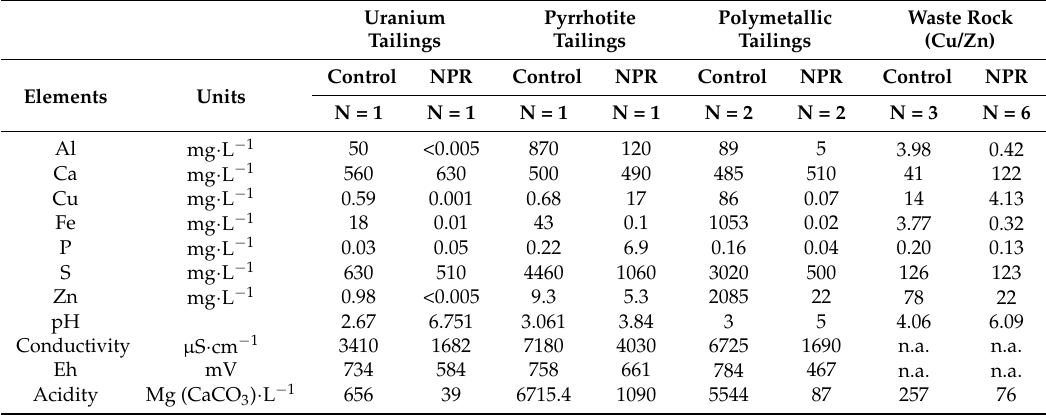
Table 2. Results of LUNE tailings slurries and effluents from the waste rock drums.